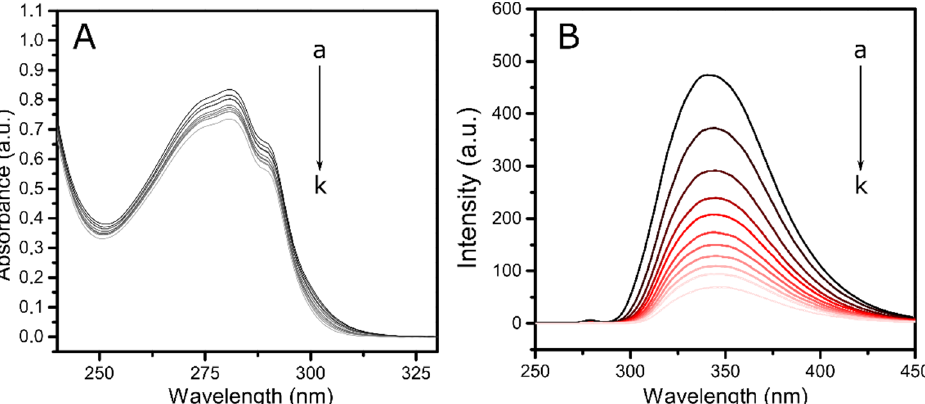
Figure 2. ( A ) UV absorption spectra of lysozyme in the absence and presence of BTS: C lysozyme = 0.02 mM; C BTS (×10 − 3 ) (a–k) = (0, 1, 2, 3, 4, 5, 6, 7, 8, 9, 10) mM. ( B ) Fluorescence emission spectra of lysozyme in the absence and presence of different concentrations of BTS at λ ex = 280 nm: T = 298 K; C lysozyme = 0.02 mM; C BTS (×10 − 2 ) (a–k) = (0, 2, 4, 6, 8, 10, 12, 14, 16, 18, 20) mM. A Stern–Volmer plot of F 0 /F against [Q] is linear for purely dynamic (K = 0) or purely static (k = 0) quenching, but curved upwards for combined quenching (eqn (3)). On this basis, a curvature of a Stern–Volmer plot is often taken to indicate combined quenching.